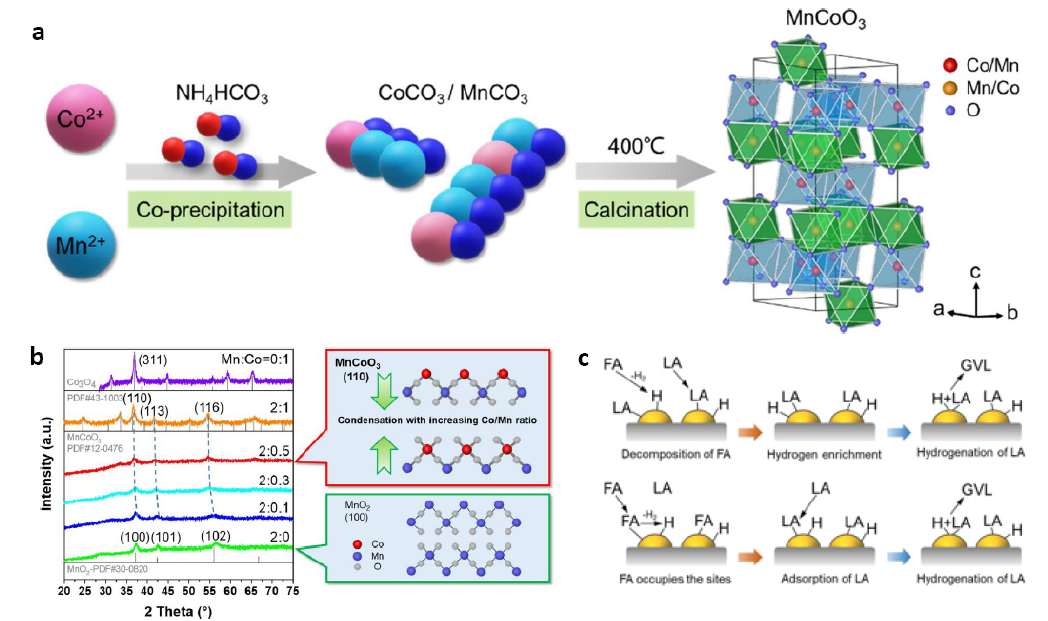
Figure 7. ( a ) Preparation process for MnCo oxide catalyst. ( b ) XRD patterns of MnCo oxide catalysts with different molar ratios. ( c ) Two proposed surface mechanisms over Mn 2 CoO x catalyst. Reproduced with permission from Reference [66]. Copyright 2020, Elsevier Ltd.